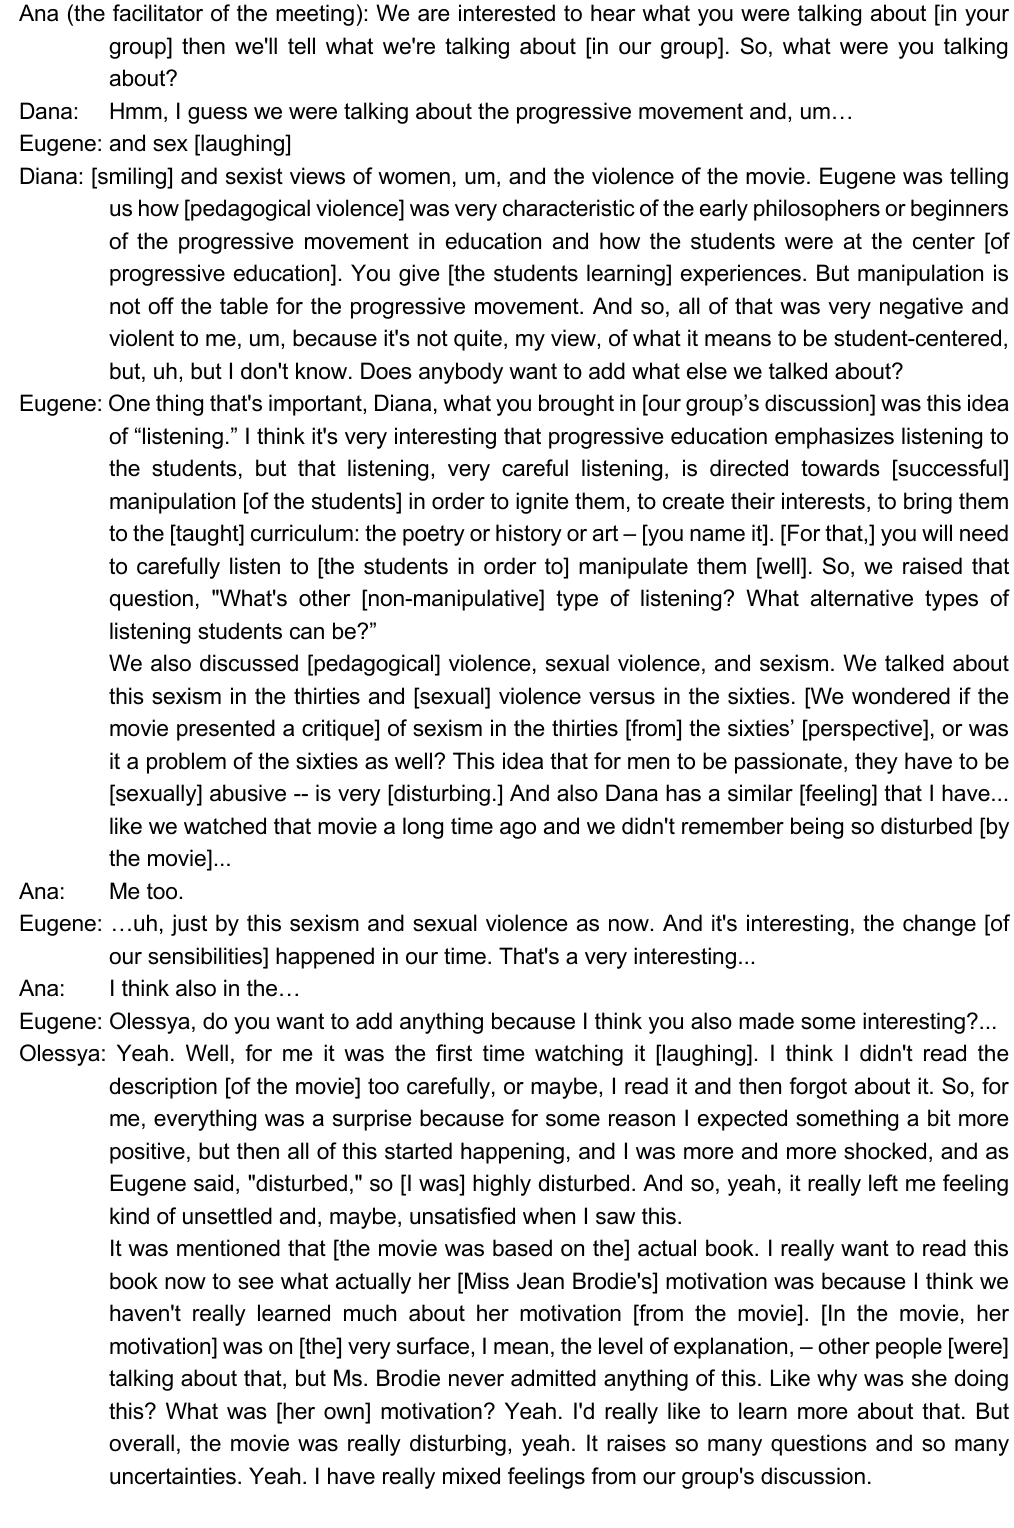
people started leaving the Zoom meeting and the last two people closed the Zoom room. The record was lightly edited for